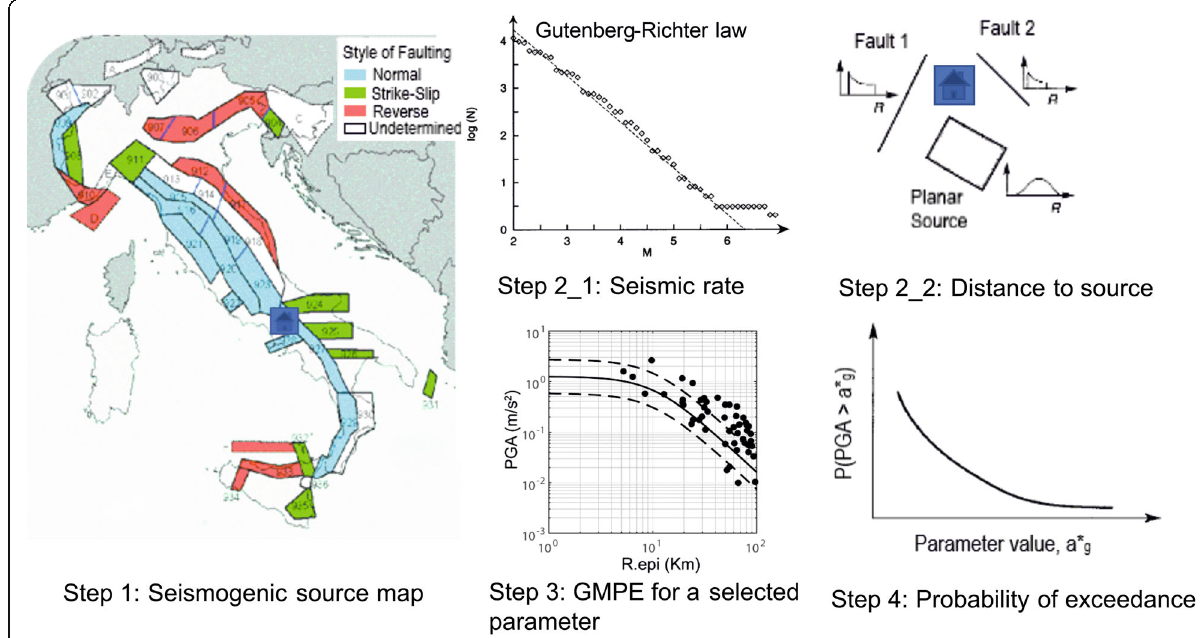
Fig. 2 Cornell ’ s probabilistic seismic hazard assessment (PSHA) explained in four steps. The blue house represents the site under